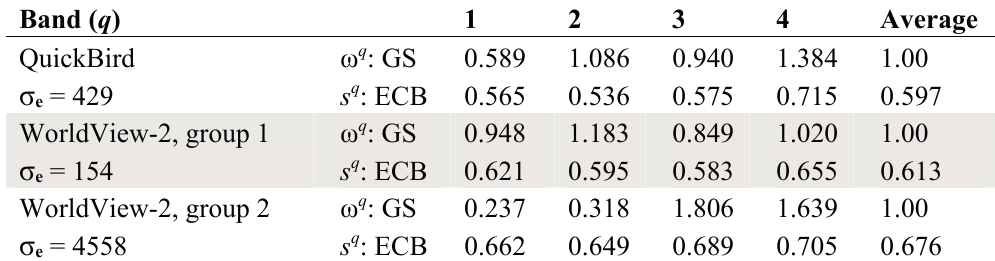
Table 14. The variance of the regression residual σ in Equation (18), the modulation e coefficient ω q in Equation (19) for the GS method and the weight parameter s q in Equation (29) averaged over the image for the ECB method for the reduced scale experiments. Their average values over all the four bands are shown in the last